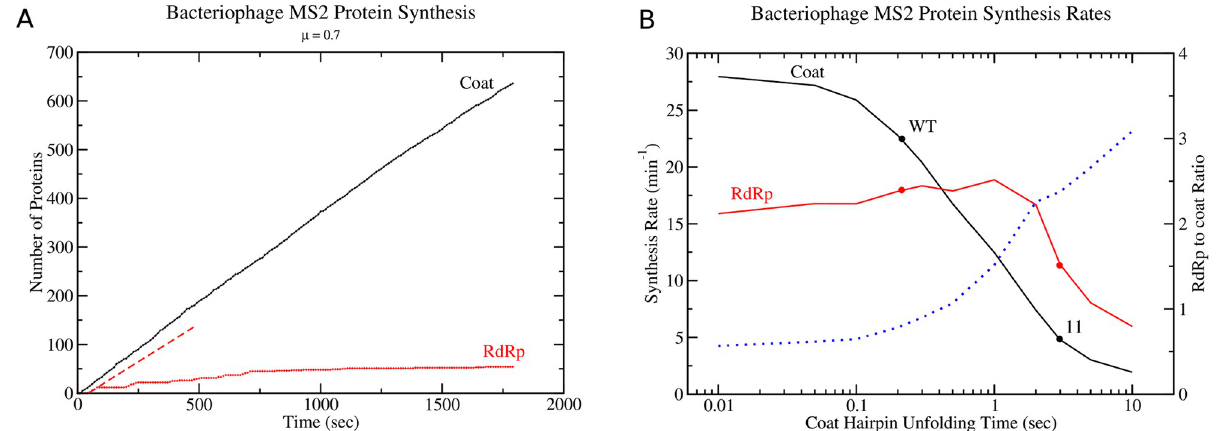
Fig 6. Synthesis rates for Coat and RdRp proteins in Bacteriophage MS2. (A) Temporal dynamics of coat protein and RdRp synthesis from bacteriophage MS2 mRNA in a bacterial cell over 30 minutes. Red dashed line corresponds to the initial synthesis rate of RdRp before coat protein binding to the TR stem-loop (c.f. Fig 4A) suppresses further synthesis. (B) Maximal Coat and RdRp synthesis rates from bacteriophage MS2 mRNA as a function of coat hairpin unfolding time. The curve is computed by varying τ explicitly in the program, with dots representing the results from u simulations with specific mutant sequences. Blue dashed line shows the ratio of RdRp to Coat protein synthesis rates.